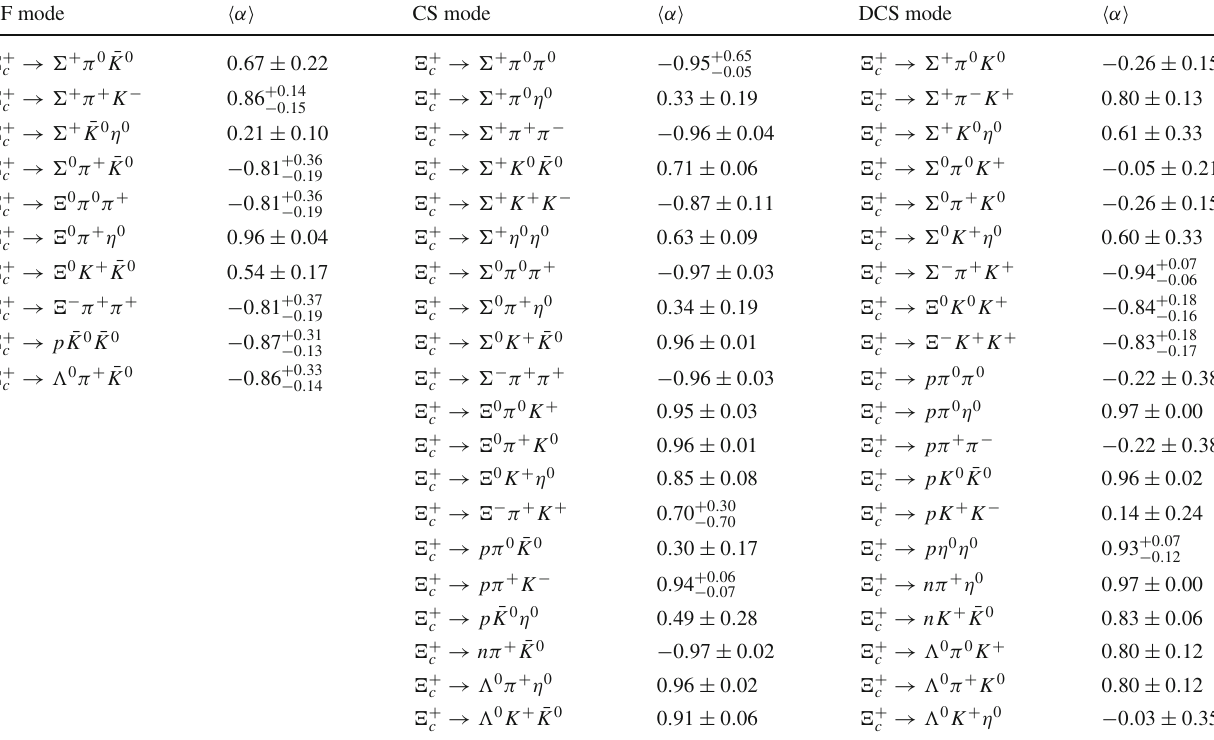
Table 10 Numerical results for (cid:8) α (cid:9) ((cid:2) + c → B n MM (cid:3)